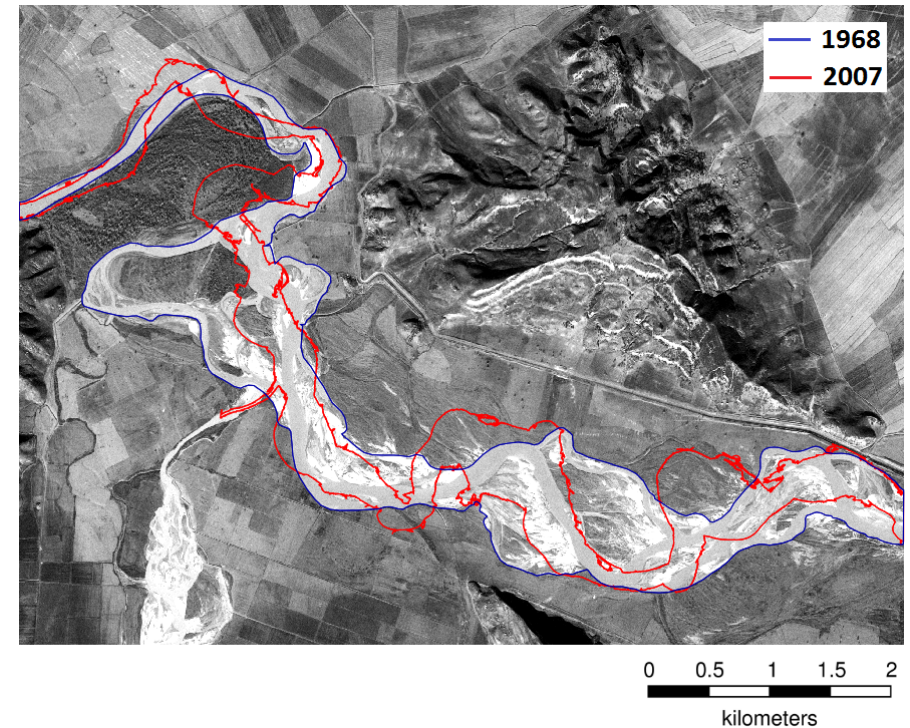
Figure 10. Historical comparison of active channel area, Vjosë River.